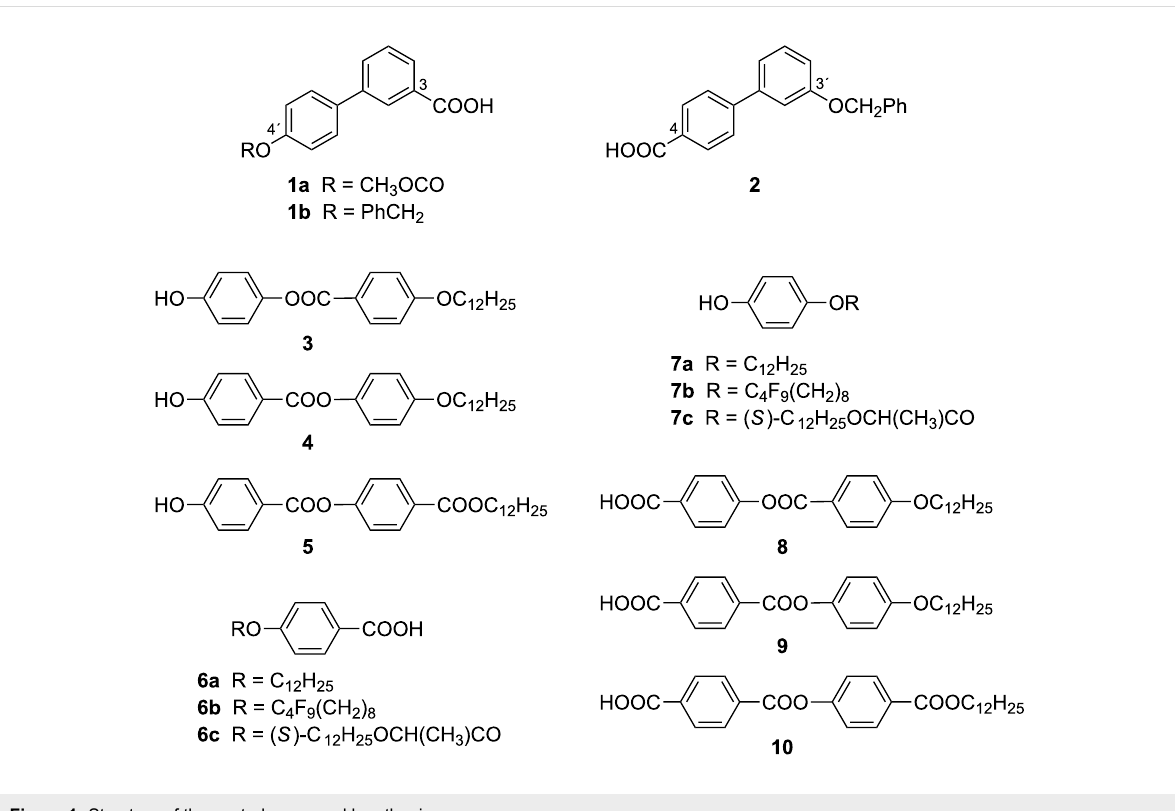
group is not compatible with the applied reaction conditions, thus, we switched to the benzyl protection of the hydroxy group (acid 1b and 2